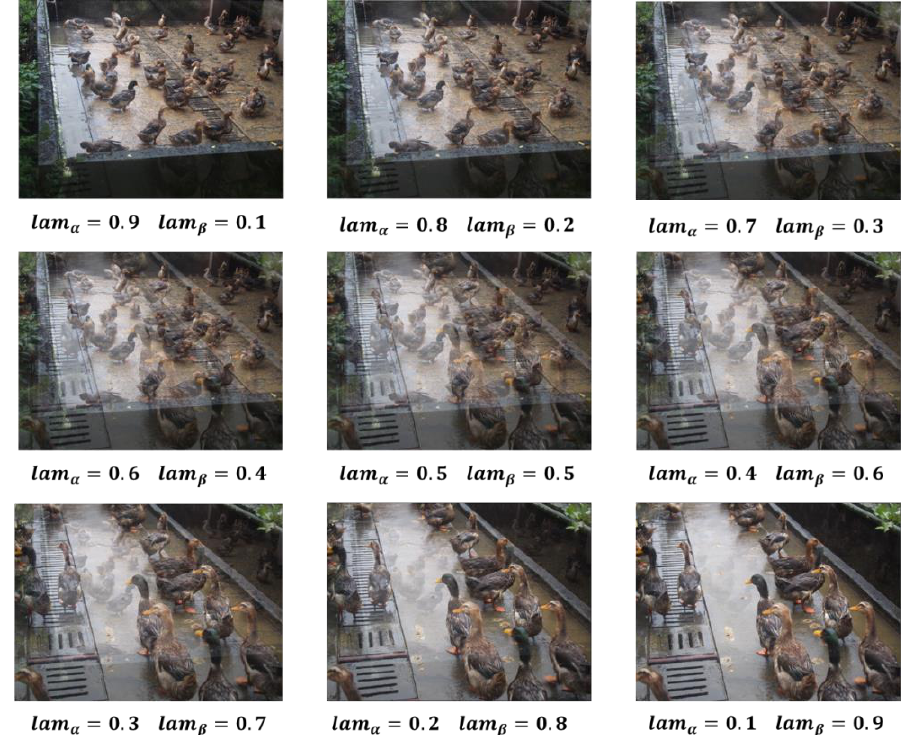
Figure 3. The results of the hemp duck data enhanced by mixup data with different fusion proportions, where lam α and lam β are the fusion proportions of the images and lam α + lam β = 1.